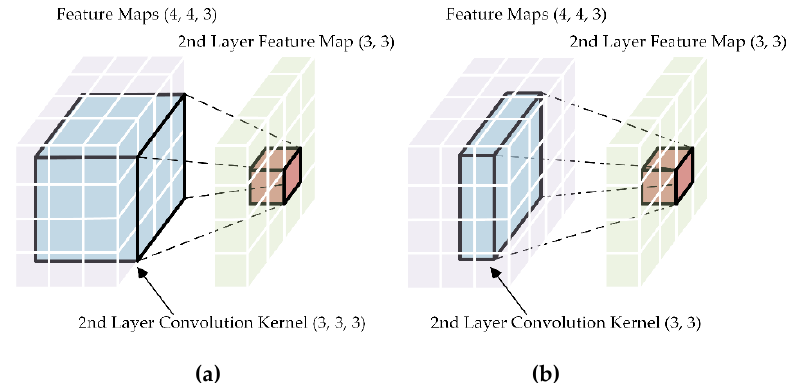
Figure 4. Schematic diagram of convolution operations. ( a ) Schematic diagram of convolution operation in the convolutional layer; ( b ) Schematic diagram of group convolution operation in the AdaFM layer.